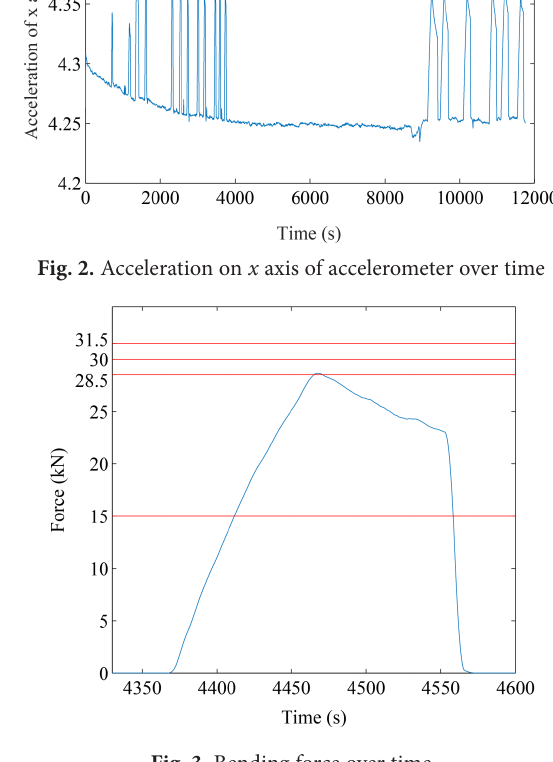
Fig. 3. Bending force over time